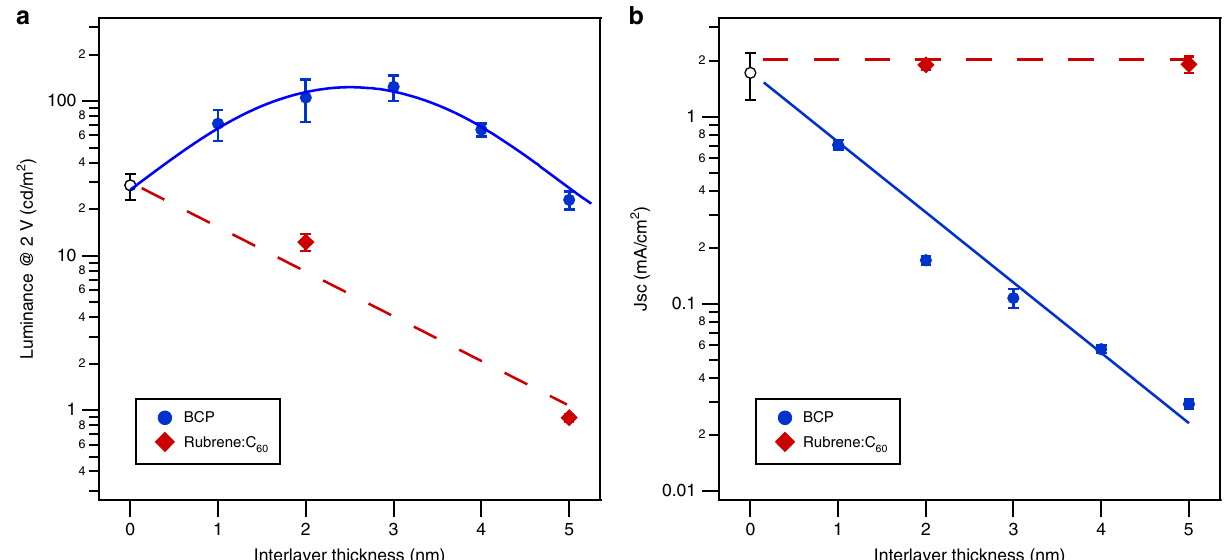
Fig. 5 Device summary. a Luminance of rubrene/C 60 OLEDs as a function of interlayer thickness. b Short-circuit current of rubrene/C 60 PV devices under AM 1.5 conditions as a function of interlayer thickness. Error bars correspond to the standard deviation of four devices. Lines are guides to the eye